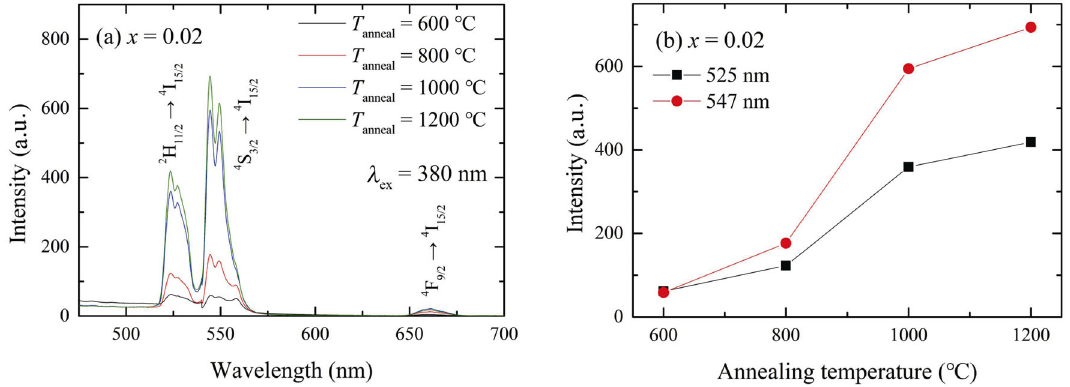
Fig. 5 (a) PL spectra of the x = 0.02 NCs annealed at T anneal ( T anneal = 600, 800, 1000, and 1200 ℃ ) under the λ ex = 380 nm photoexcitation. (b) Emission intensities at 525 and 547 nm of x = 0.02 NCs as a function of the annealing temperature ( T anneal